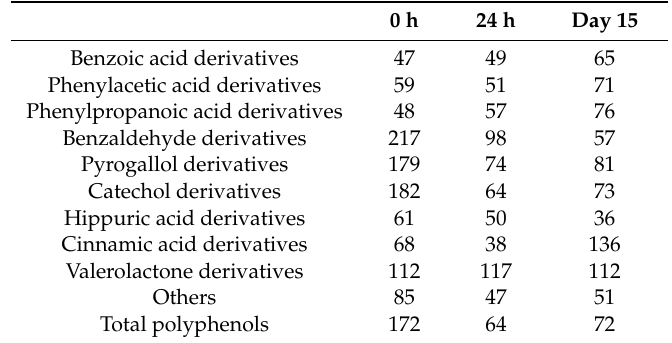
Table 3. Coe ffi cient of variation (%CV) of (poly)phenolic metabolites in fasting urine samples after acute and 14 days of mango beverage